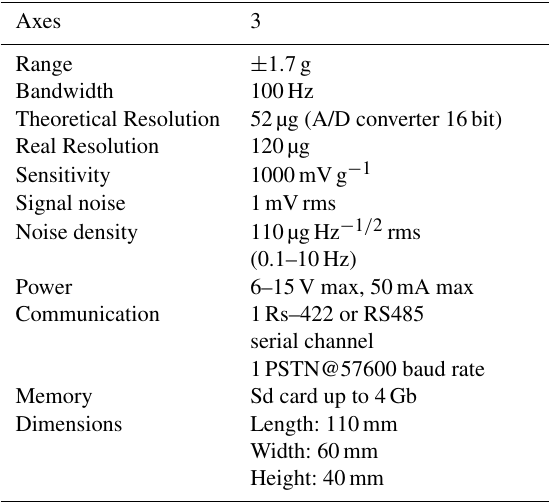
Table 1. Technical specifications of the ADEL D600003A MEMS